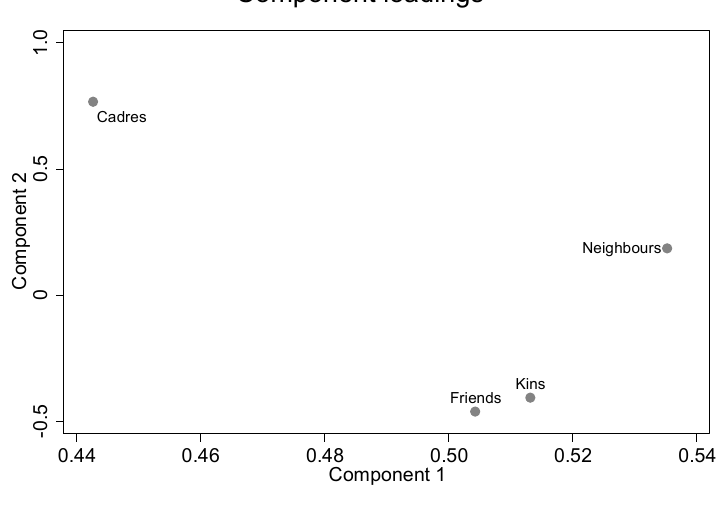
Figure 2. Loading diagram for PCA.